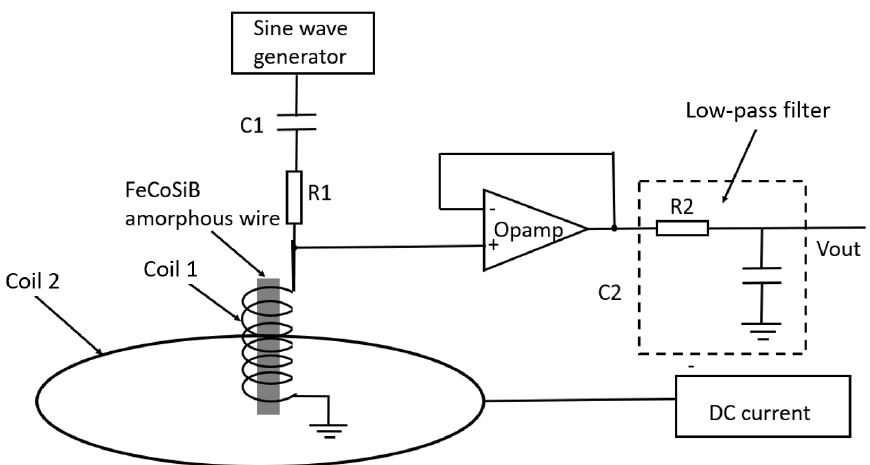
Figure 4. Block diagram of the setup to measure the DC voltage of the coil with FeCoSiB amorphous wire.